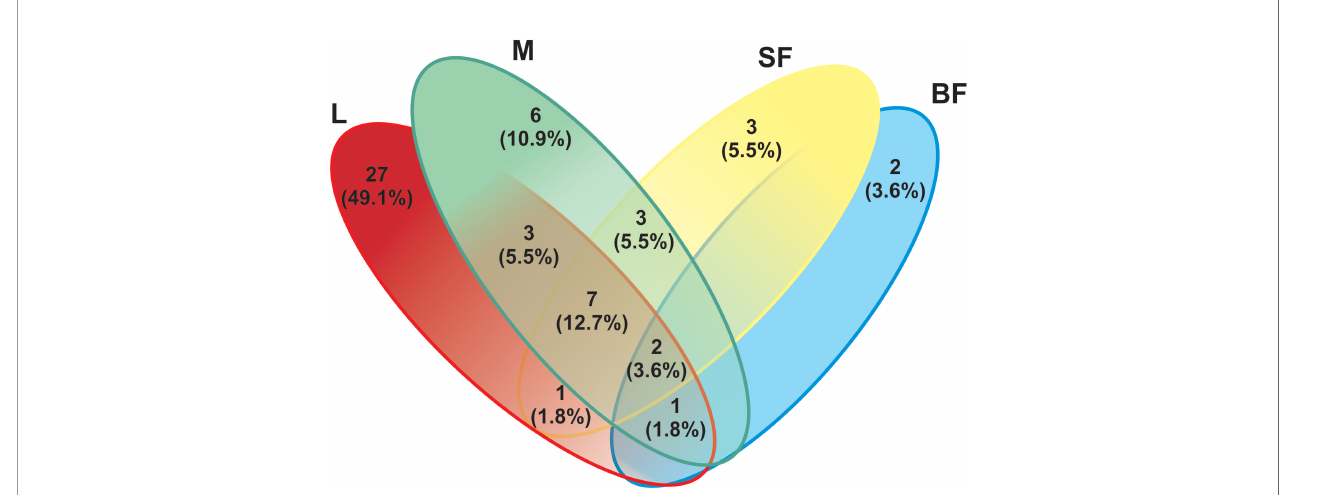
FIGURE 5 | Venn-diagram depicts the number of fungal ITS Operational Taxonomic Units (OTUs) overlap and non-overlap between Cx. quinquefasciatus instars. A total of 55 fungal OTUs (based on the sequencing of the ITS-2 regions) were detected. L, larvae; M, male; SF, sucrose-fed females; and BF, blood-fed